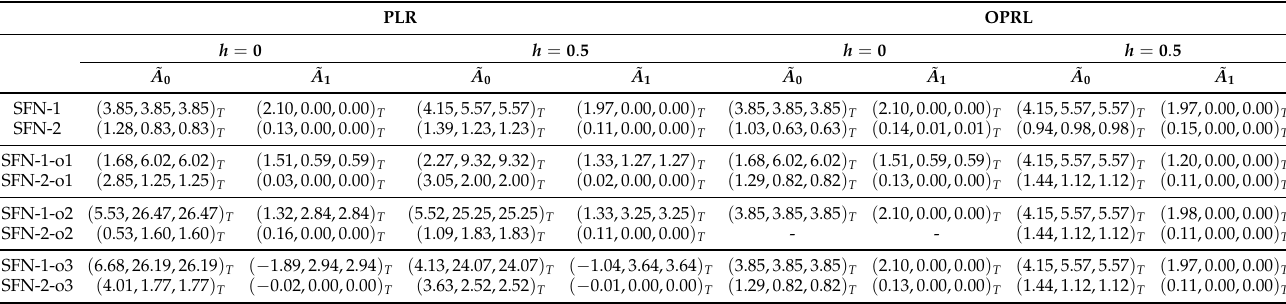
Table 5. Parameters of fuzzy regression models ˜ A 0 and ˜ A 1 estimated by the possibilistic linear regression (PLR) and the PLR combined with the omission approach (OPRL) on datasets (first column) with symmetric fuzzy observations. Settings of the adjustable parameter h are stated in the second line.